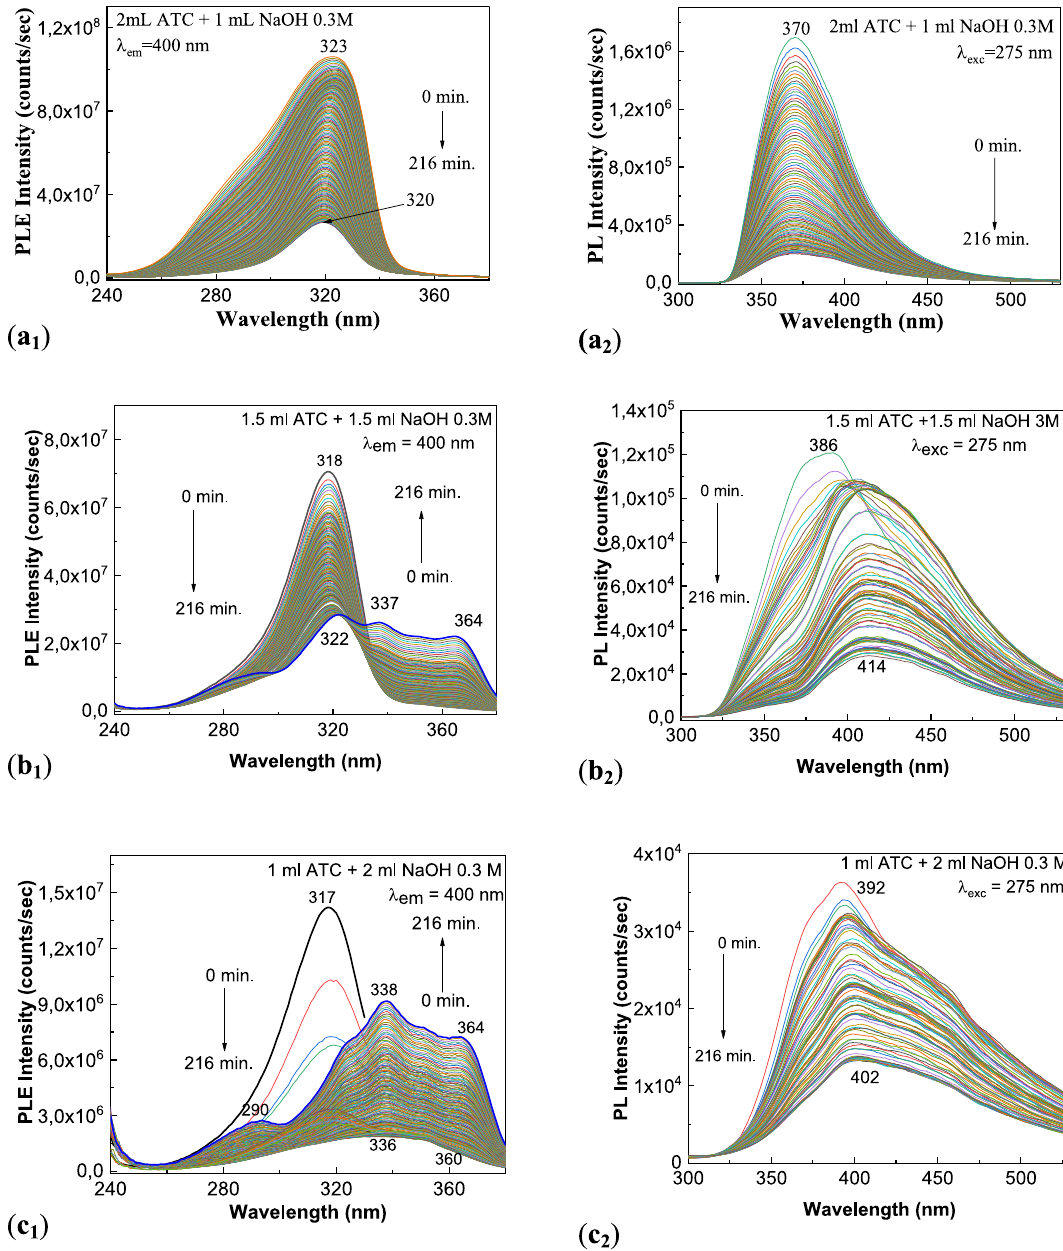
Figure 3. PLE (1) and PL (2) spectra of the aqueous solutions of: 2 ml ATC 2 mg/ml interacted with 1 ml NaOH 0.3 M ( a 1 , a 2 ); 1.5 ml ATC 2 mg/ml interacted with 1.5 ml NaOH 0.3 M ( b 1 , b 2 ); and 1 ml ATC 2 mg/ml interacted with 2 ml NaOH 0.3 M ( c 1 , c 2 ) before and after the exposure at UV light for 216